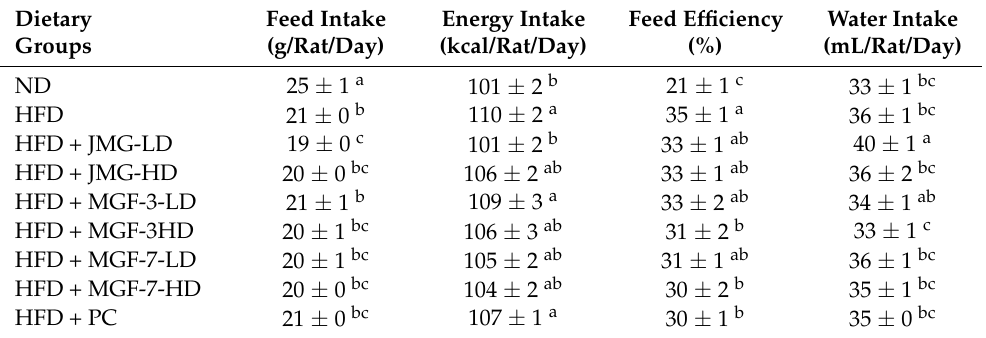
Table 2. Effects of Mei-Gin formulas on feed intake, energy intake, feed efficiency, and water intake in high-fat diet-induced obese rats.